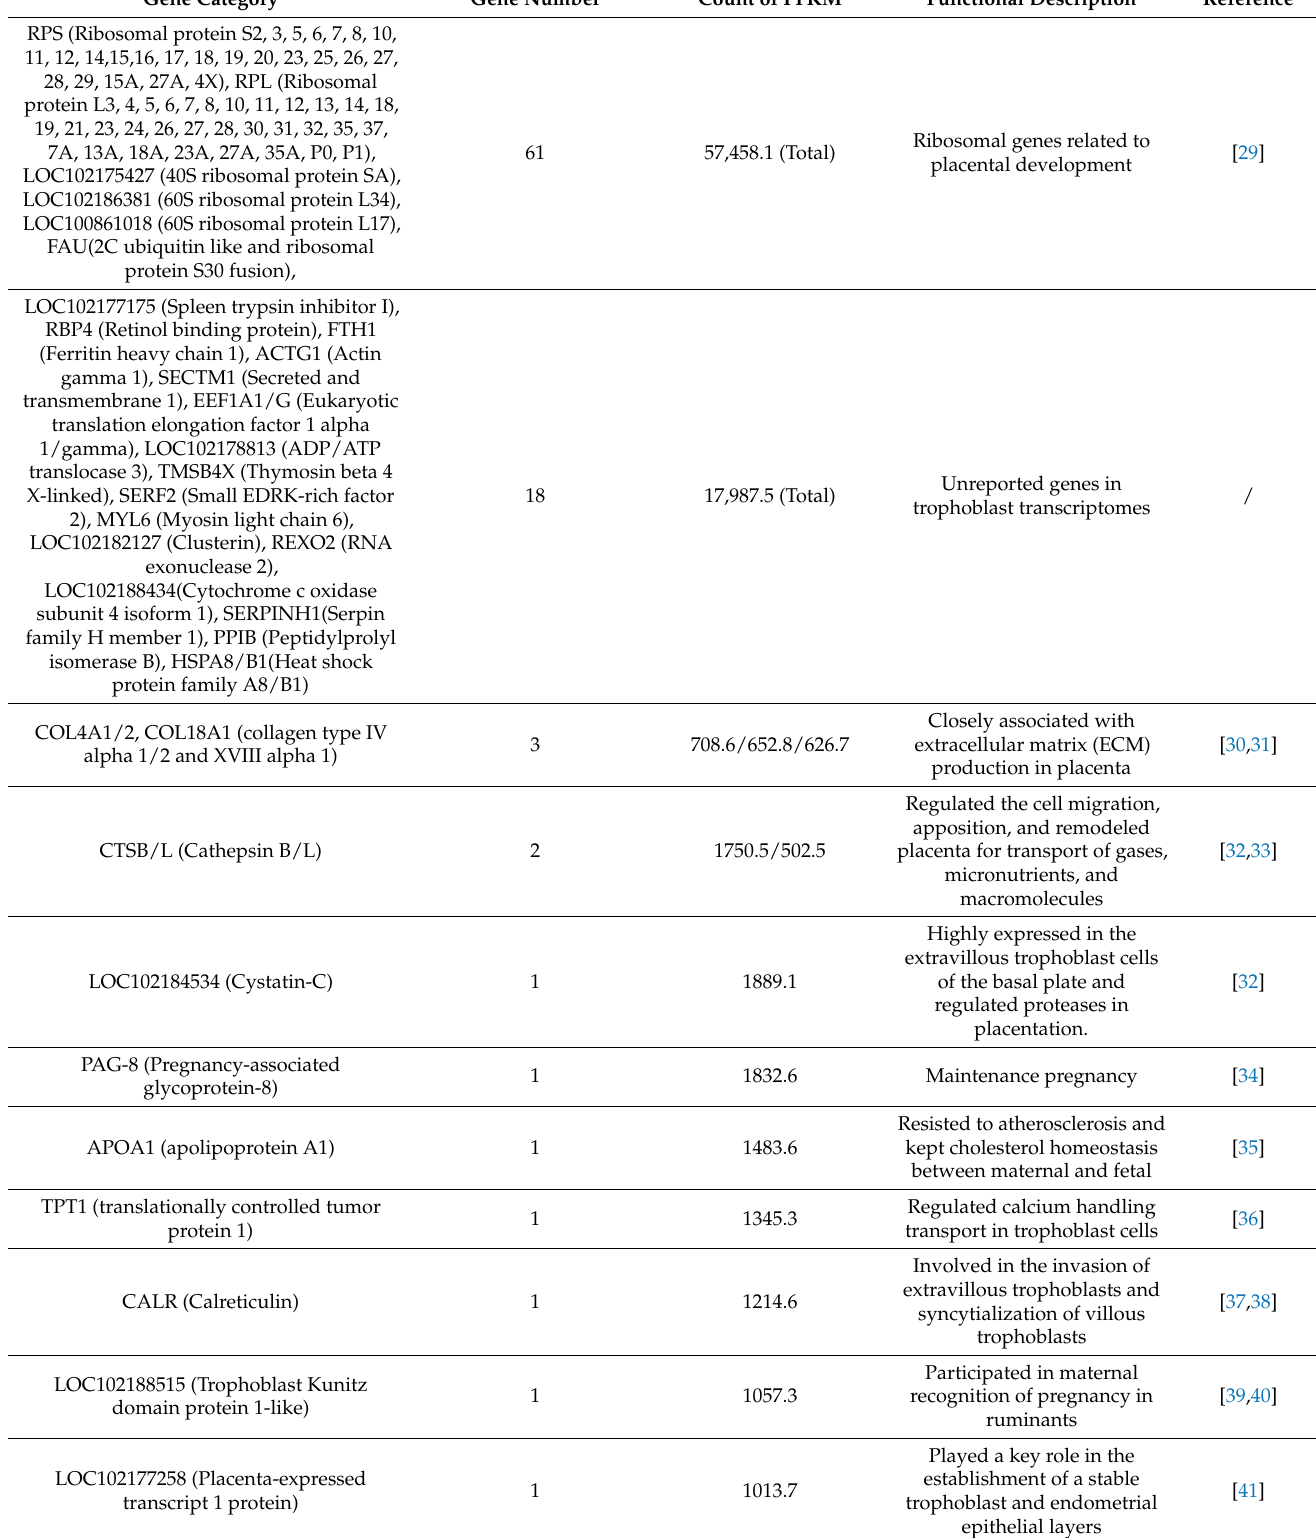
Table 1. The information of top 100 CEGs related to placenta development at early